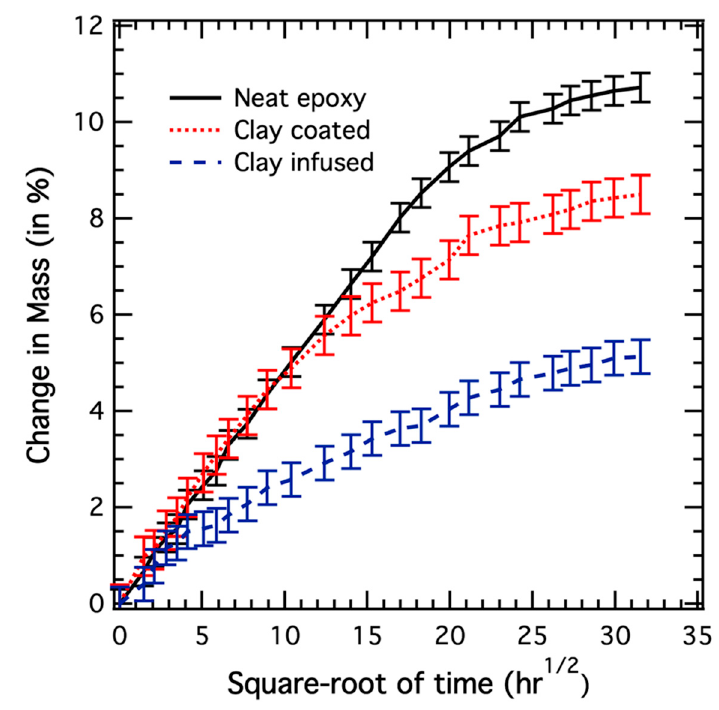
Figure 5. Change in mass in carpet composites as a function of the square root of time.